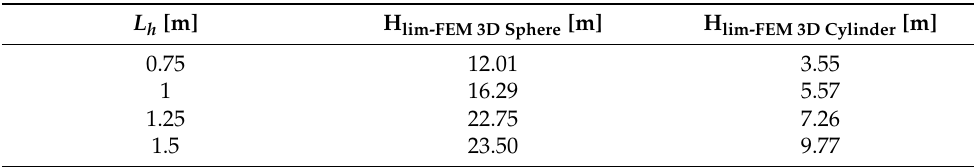
Table 2. Comparison between 3D FEM limit hydraulic level for different values of L h and the den’s geometry.